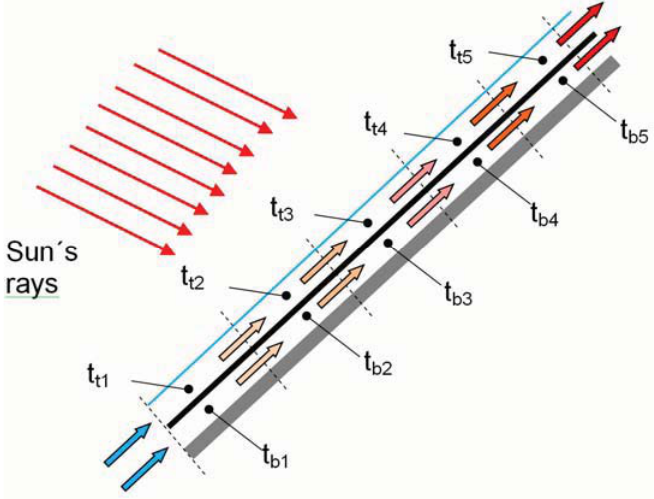
Figure 2: Model of the front and back pass collector